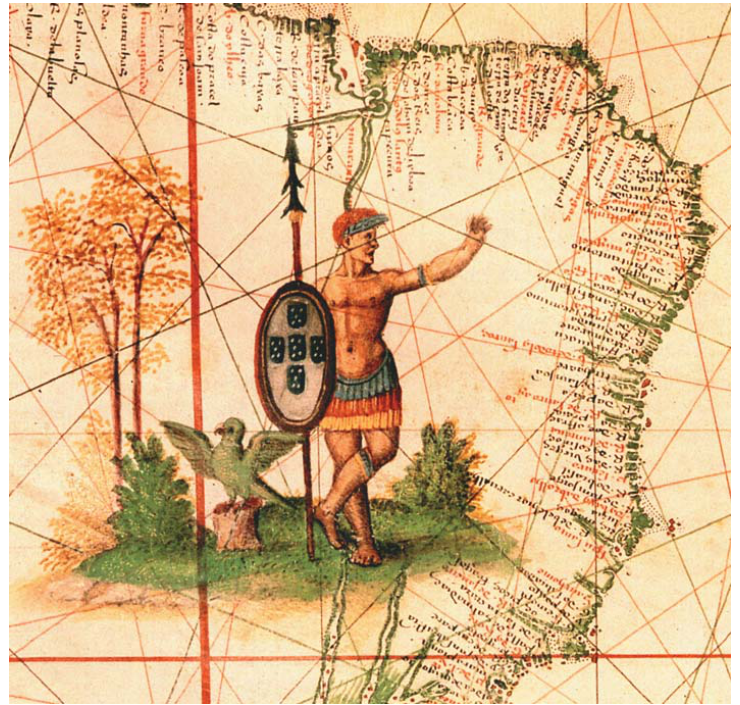
Fig. 8 – Detail of the Planisphere made by Pêro Fernandes, 1545 (Farinha 1999).